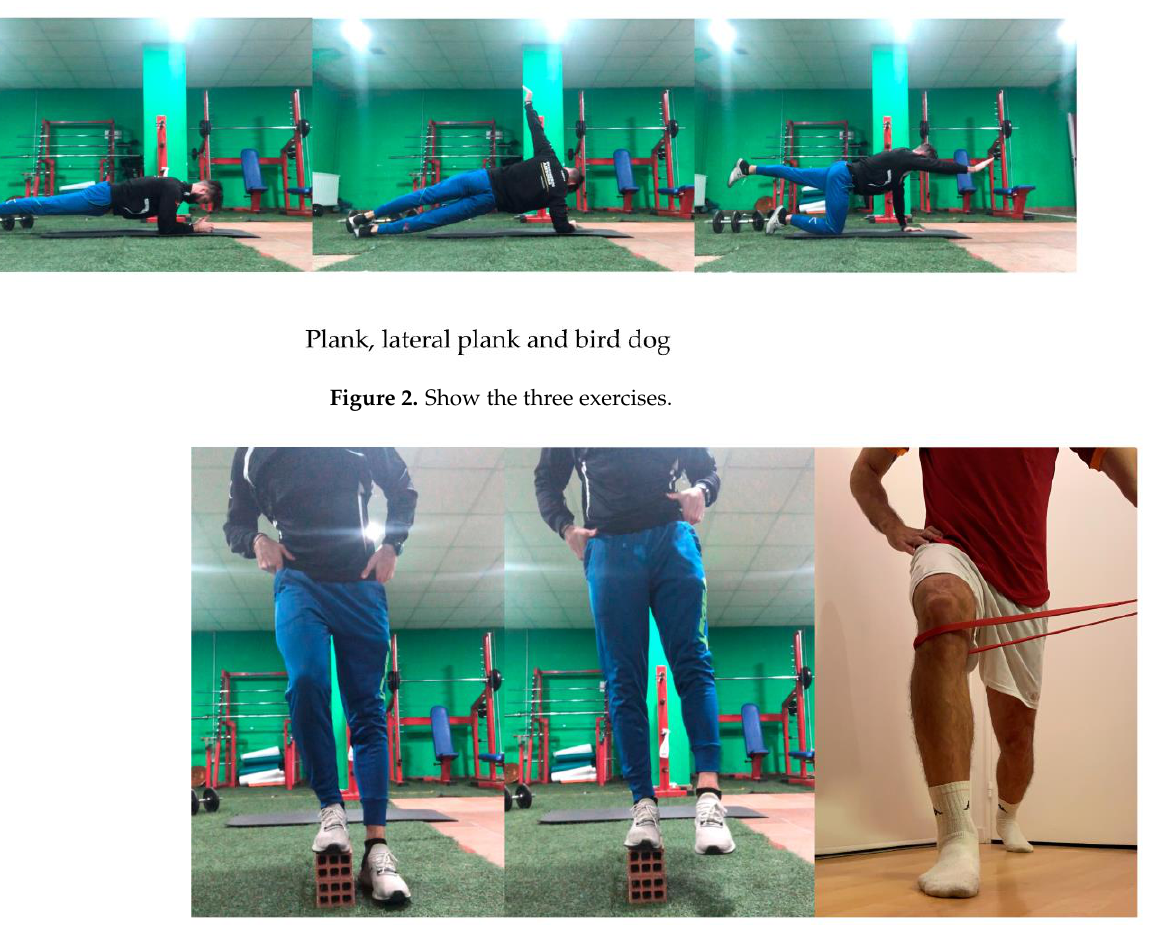
Figure 3. show both